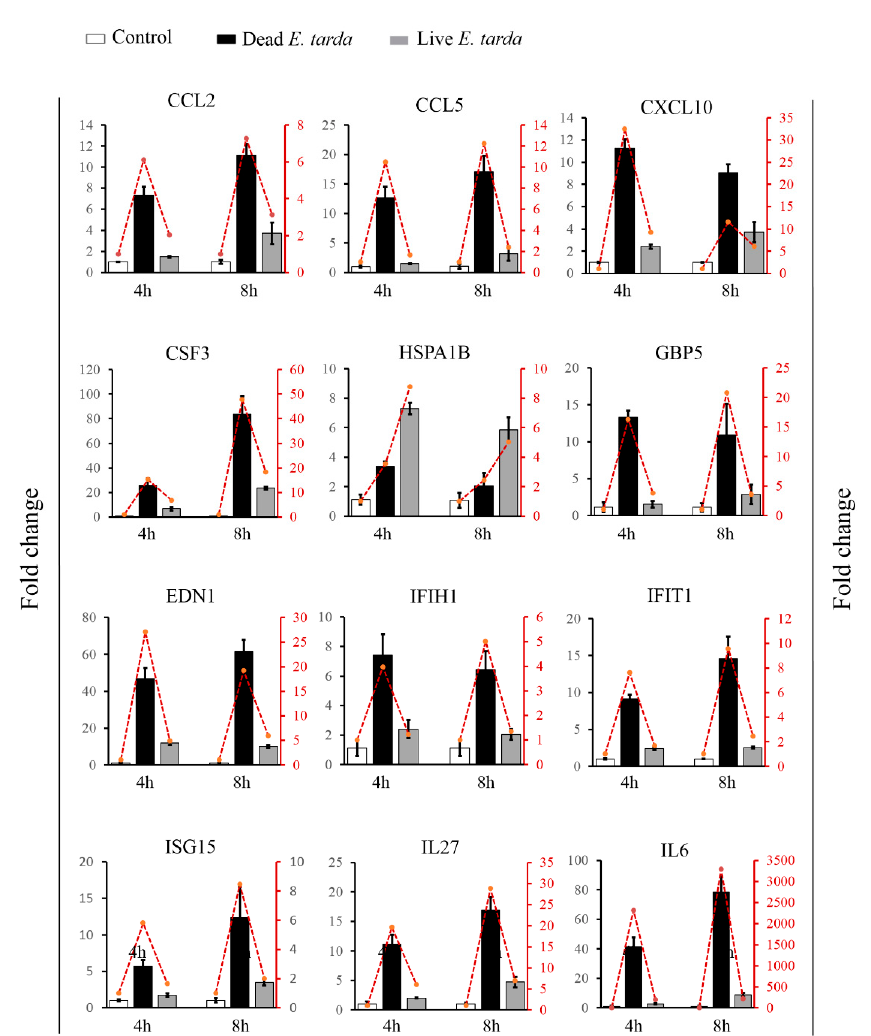
Figure 3. The expression patterns of 12 di ff erentially expressed genes (DEGs) determined by qRT-PCR. RAW264.7 cells were treated with or without (control) dead or live Edwardsiella tarda for 4 h and 8 h, and the expressions of the 12 selected DEGs were determined by qRT-PCR. Values are the means of triplicate experiments and shown as means ± SEM. The histograms represent the results of qRT-PCR; the line charts represent the results of